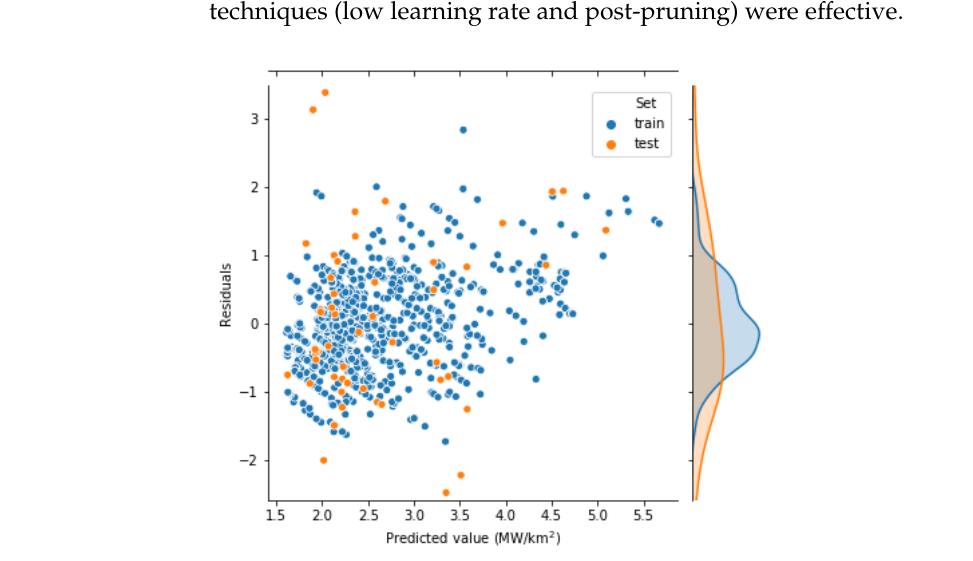
Figure 4. Residual plot showing prediction errors for train and test sets. The accompanying density plot (right-hand side) shows that the distribution of residuals centers around zero for both sets used in model evaluation.